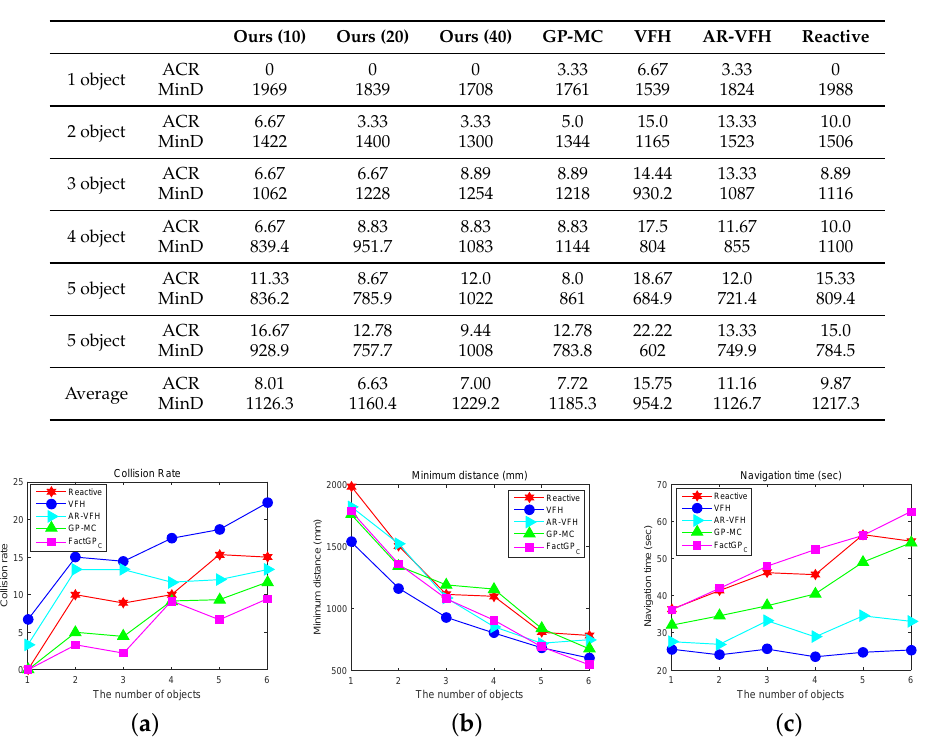
Table 1. Average collision rate (%) and minimum distance (mm) of our FactGP C at three different rank ratios (10%, 20%, and 40%) as well as GP-MC, VFH, AR-VFH, and Reactive when there are different numbers of moving obstacles.